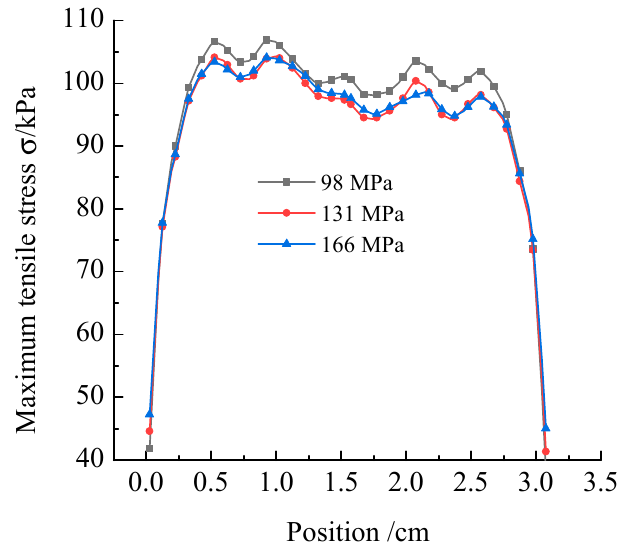
Figure 16. Variation of stress at the top of base under different moduli of elasticity polymer lifting.